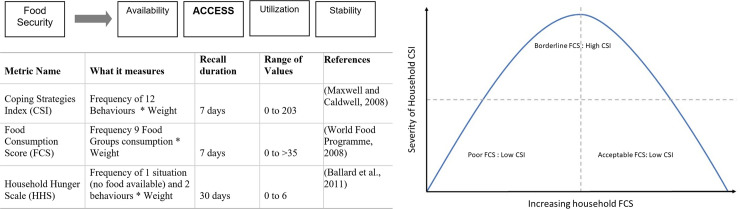
Metrics for food security assessments.(a) Diagram shows the four pillars of food security. We used three standardized metrics to explore household access to foods available at their village location [53, 56–58]. For more details please see S2 File. (b) Hypothesized relationship of FCS and CSI—CSI will be positively correlated with FCSs until households attain higher FCS in borderline category or acceptable FCSs. After attaining higher FCSs we expect to see a negative association with CSI.